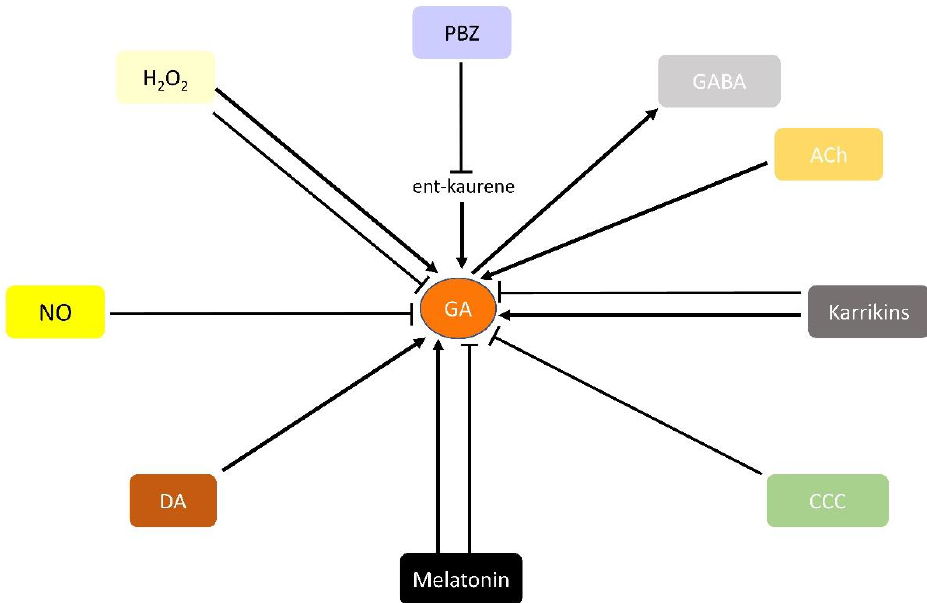
Figure 3. Schematic representation of the relations between GAs and potential PGRs. Arrows indicate activation and blunt-end lines indicate repression or inhibition. See text for details and references. ACh: acetylcholine, CCC: clorocholine chloride, DA: dopamine, GA: gibberellins, GABA: γ -aminobutyric acid, H 2 O 2 : hydrogen peroxide, NO: nitric oxide, PBZ: paclobutrazol.